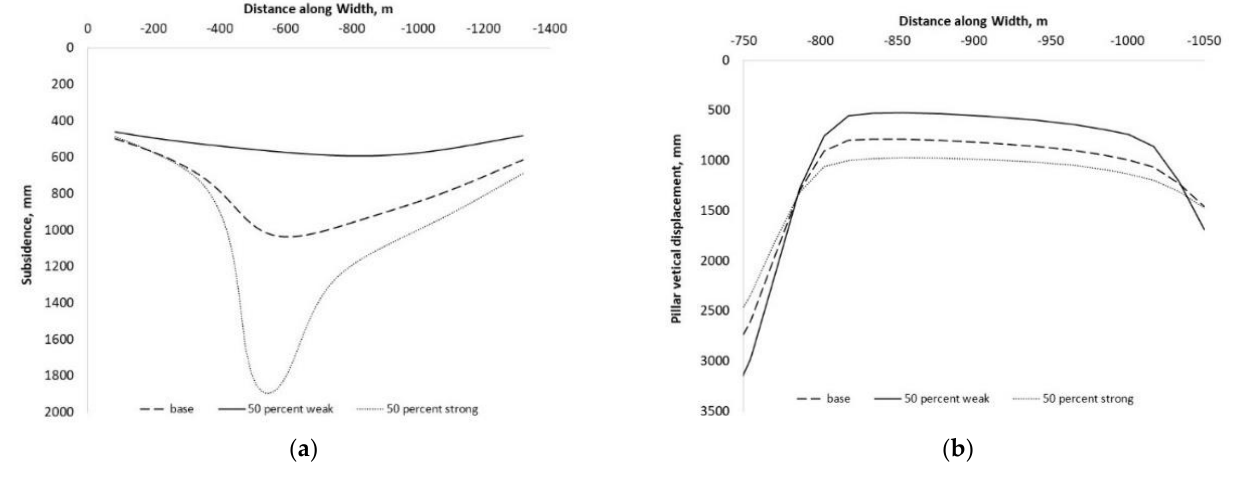
Figure 10. ( a ) ground subsidence after excavating longwall 302; ( b ) Vertical displacement at 900 m below the ground surface (77 m above the mining seam) at the pillar.